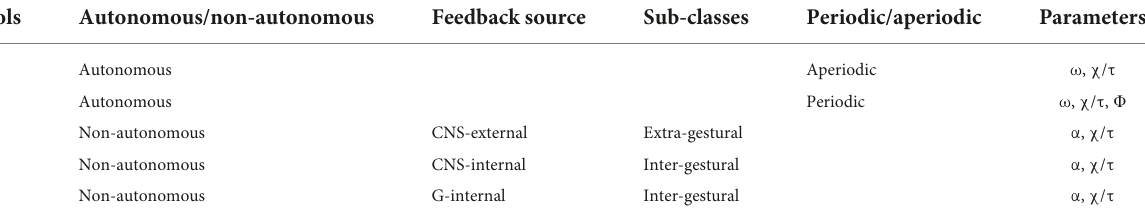
TABLE 1 Summary of